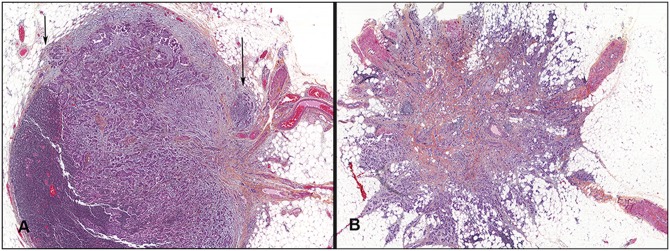
Photographs of metastatic tumor tissue in axillary lymph nodes demonstrating extra-nodal extension.A, the partial type with foci of extra-nodal extension (arrows); B, complete type with total destruction of the lymph node capsule (x 200 magnification).